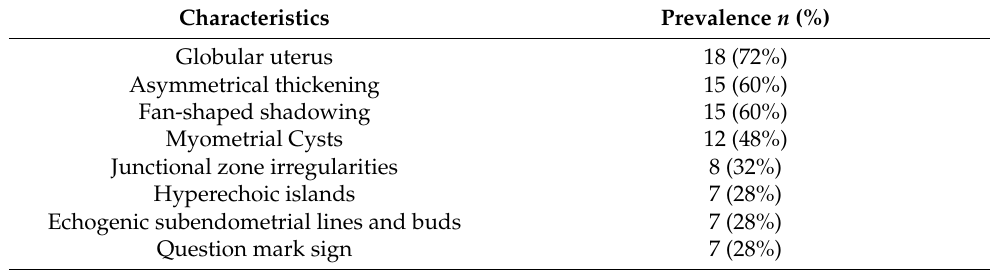
Table 2. Sonographic features of adenomyosis in the adenomyosis group (25 patients), assessed by an expert